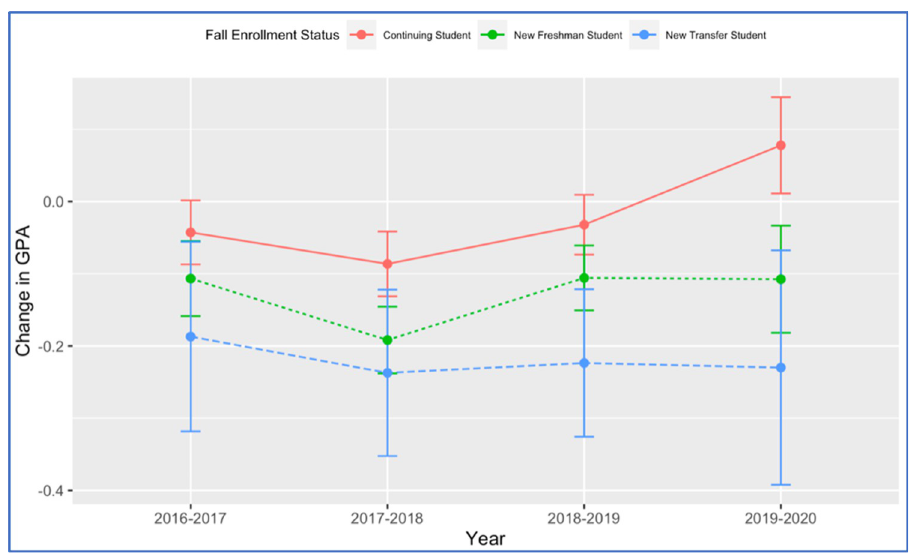
Fig 5. Comparing GPA change (SP—FA) by fall enrollment status over four academic years. The line segments represent 95% confidence intervals around the means represented by closed circles.